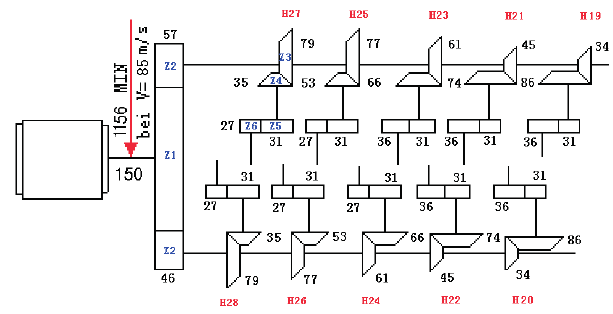
Figure 36. Driving chain of a gearbox for a high-speed finishing mill.